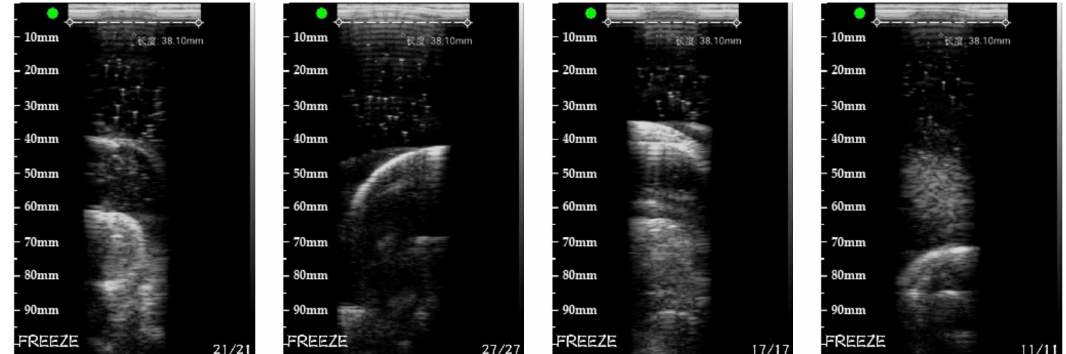
Figure 24. Cross-sectional images collected by the probe.